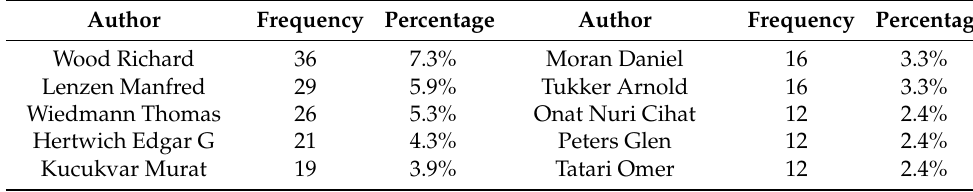
Table 1. Top 10 authors based on frequency.